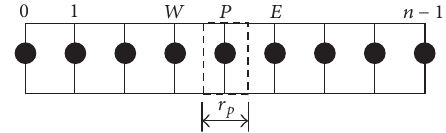
Figure 4: Computational model of the control